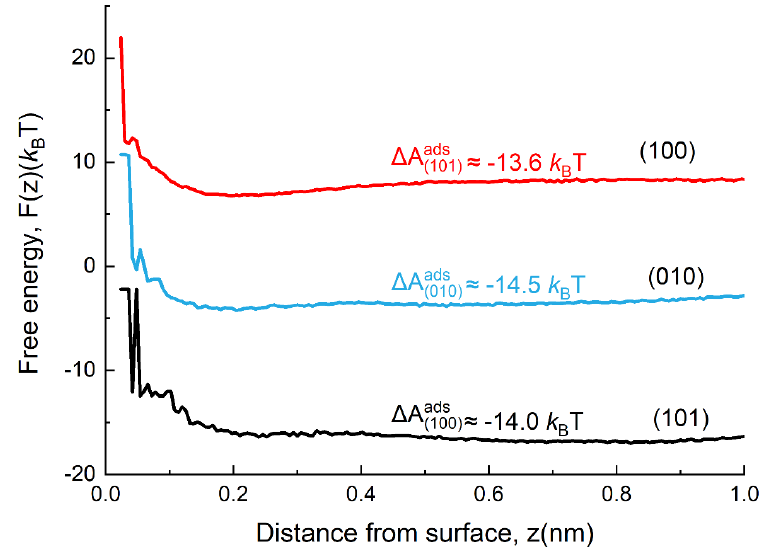
Figure 8. Free energy as a function of the PK3 center–of–mass distance from the (100), (010), and (101) surfaces of ZSM-5 computed using USMD.